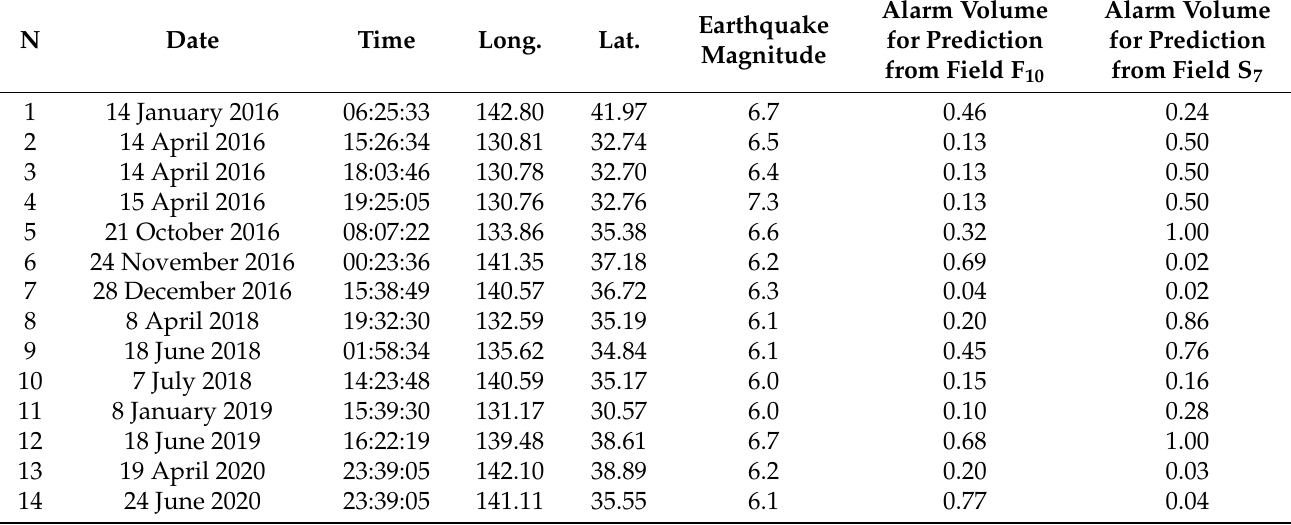
Table 1. Japan. Results of forecasting earthquakes with magnitudes m ≥ 6.0 from field F 10 and field S 7